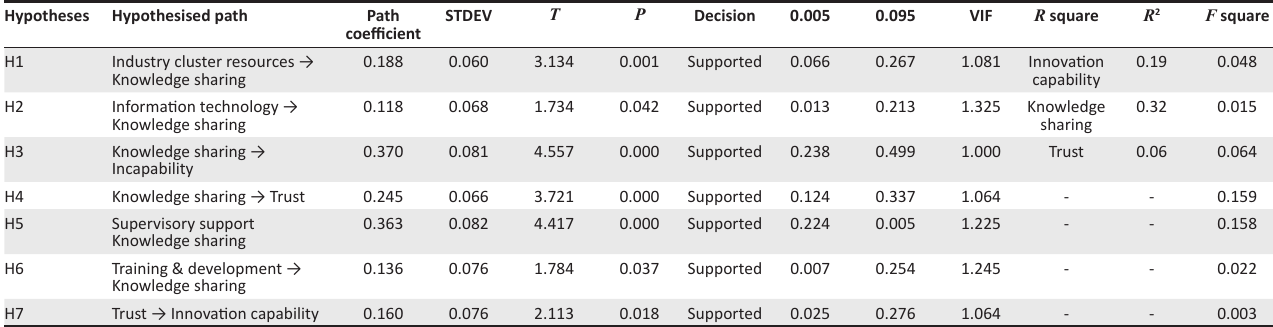
TABLE 5: Direct effect of hypotheses. Hypotheses Hypothesised